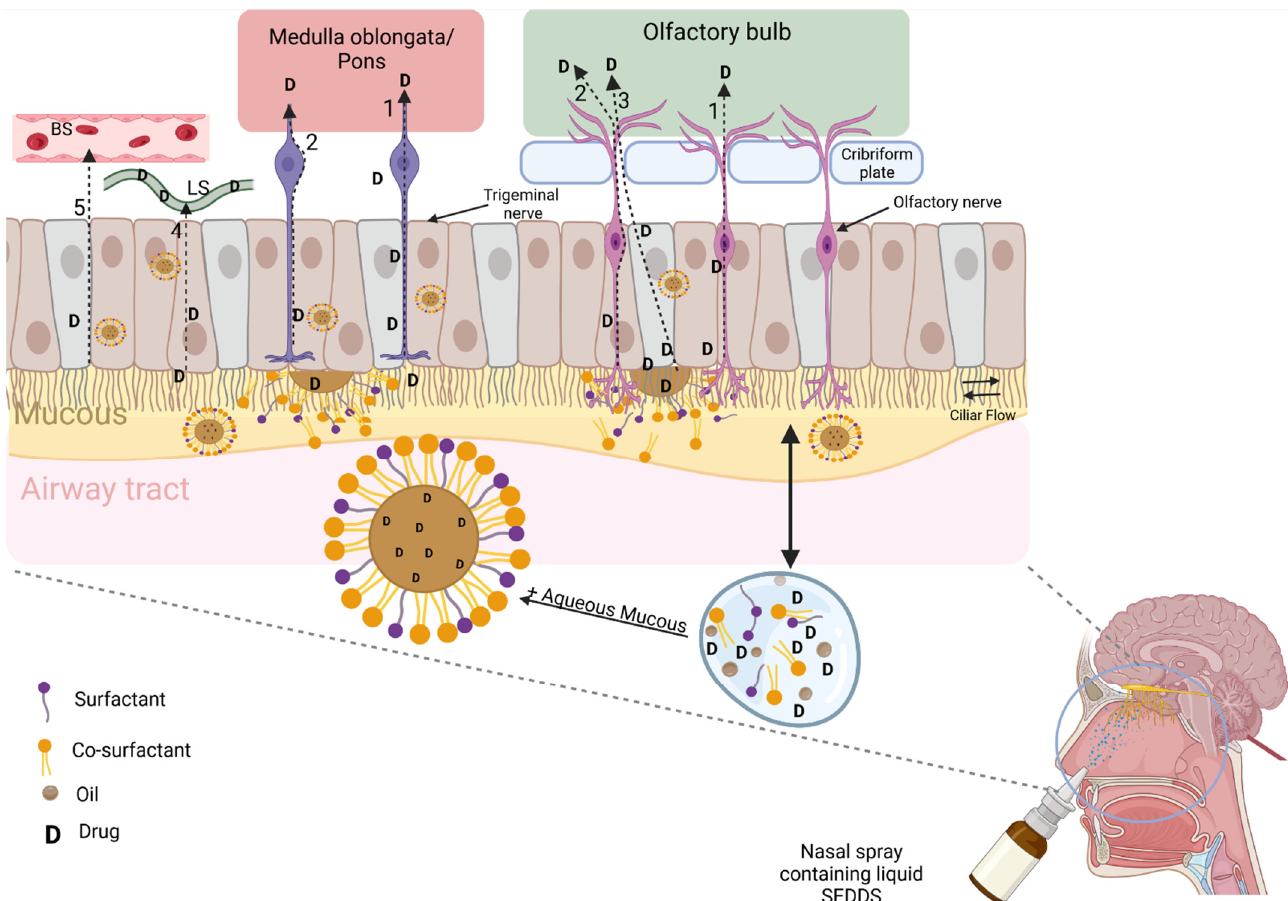
Figure 3. Intranasal delivery of drugs loaded in self-emulsifying drug delivery systems (SEDDS). After self-emulsification, drugs can be directly delivered to the brain through olfactory pathway—by intracellular (1), paracellular (2) or transcellular/intracellular (3) mechanisms—and through trigeminal pathways—by intracellular (1) or paracellular (2) mechanisms. Molecules can also reach the brain by indirect systemic pathways—from lamina propria, drugs can be absorbed by lymphatic system (LS) (4) or blood system (BS) (5)—reaching systemic circulation, crossing the blood–brain barrier and, in the end, the brain. Created with BioRender.com, accessed on 17 July 2022.